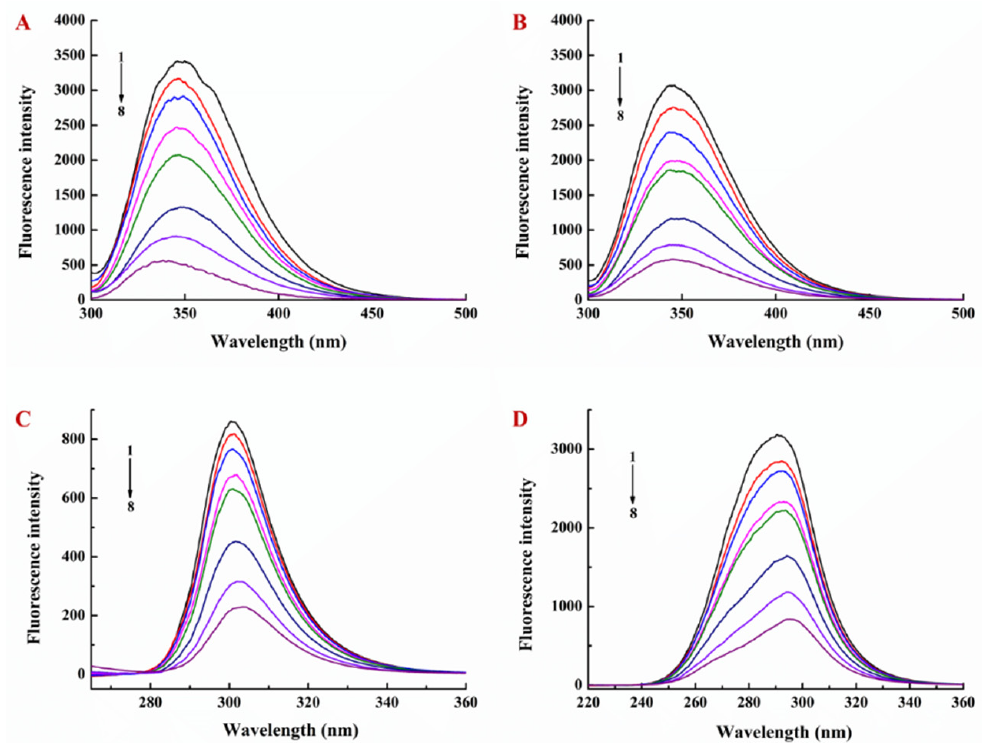
Figure 2. Fluorescence emission spectra of EGCG-lysozyme ( A ) at 25 ◦ C and ( B ) at 35 ◦ C. Synchronous fluorescence spectra of EGCG-lysozyme at 25 ◦ C, ( C ) ∆ λ = 15 nm, and ( D ) ∆ λ = 60 nm. To further investigate the effect of EGCG on LY fluorescence quenching, fluorescence intensity was measured at 25 ◦ C and 35 ◦ C. The maximum diffusive collision quenching rate constant of the quenching agent for biological macromolecules was reported to be 2.0 × 10 10 L/mol · s in the previous study [30]. The dynamic quenching constant (K sv) , reflecting the interaction of EGCG with LY, was calculated as 3.13 × 10 4 L · mol − 1 at 25 ◦